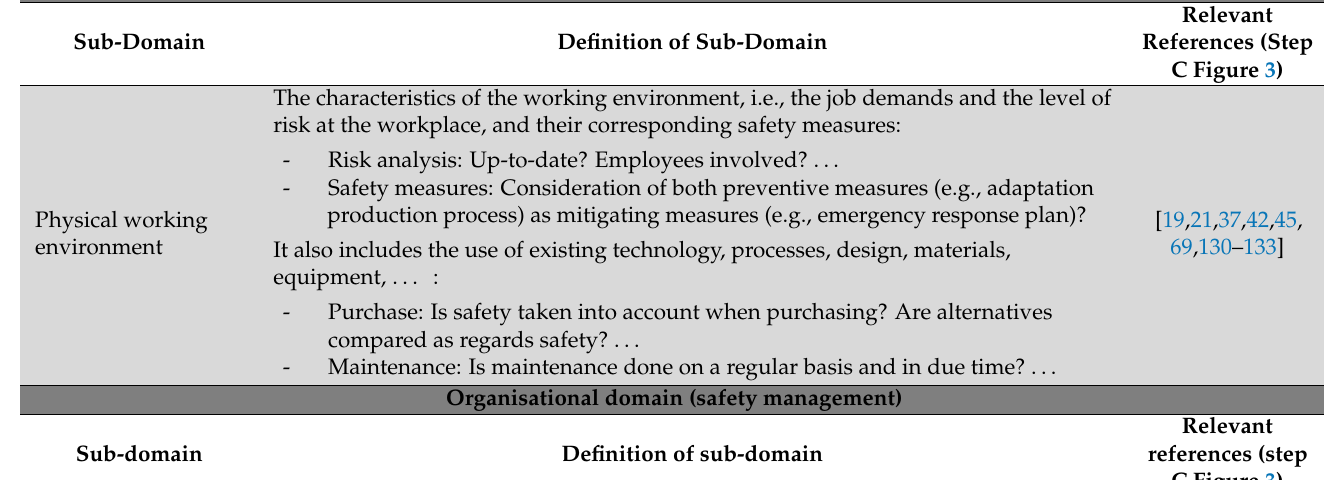
Table 9. Observable domains of safety culture and their